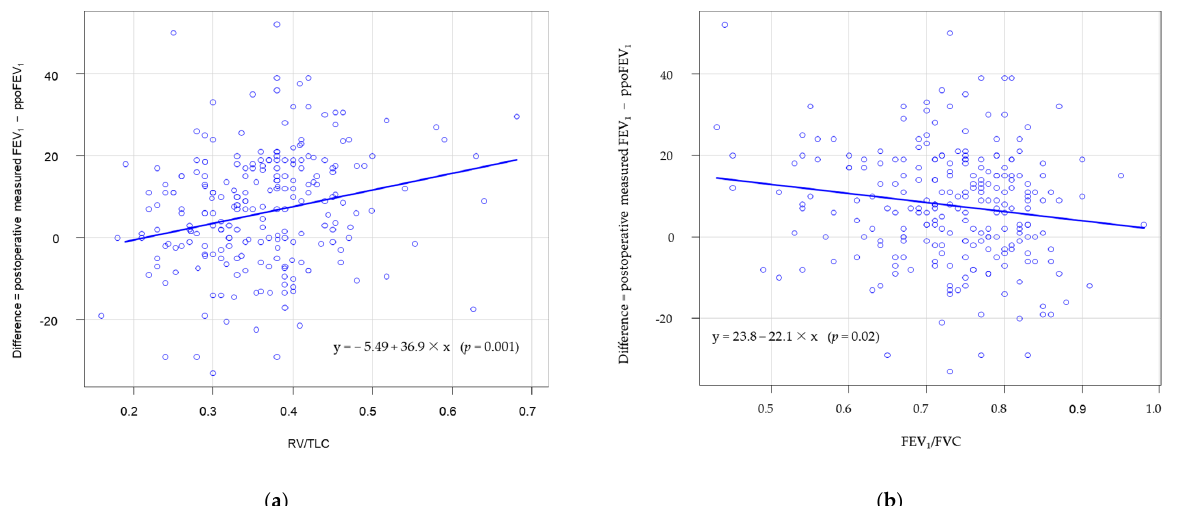
Figure 1. Correlation of difference with ( a ) RV/TLC and ( b ) FEV 1 /FVC.